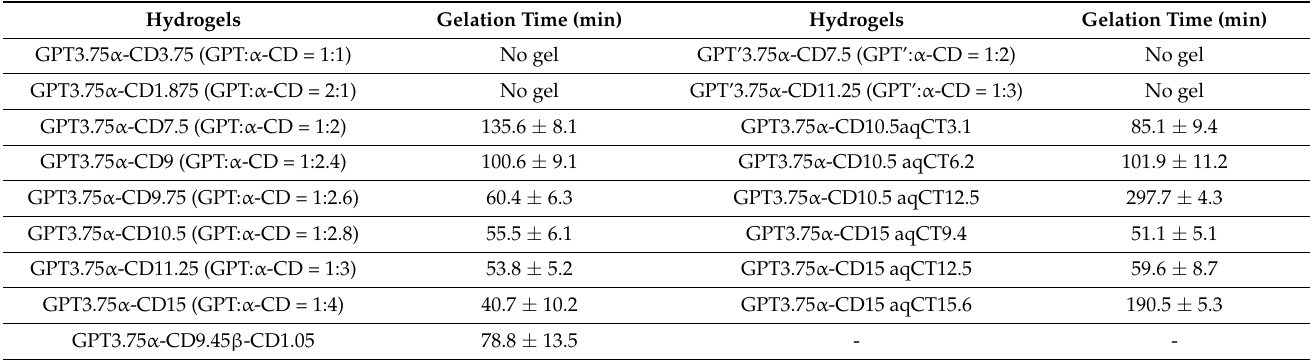
Table 2. Gelation time of various hydrogel formulations.